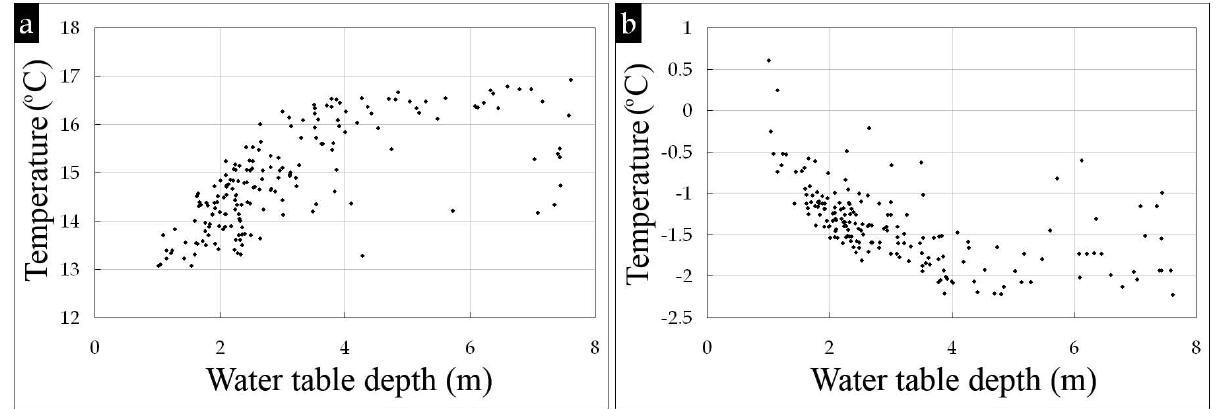
Fig. 8. The cross-relationships between the water table depth and both (a) daytime land surface temperatures and (b) nighttime land surface temperatures on 17 January 2007.